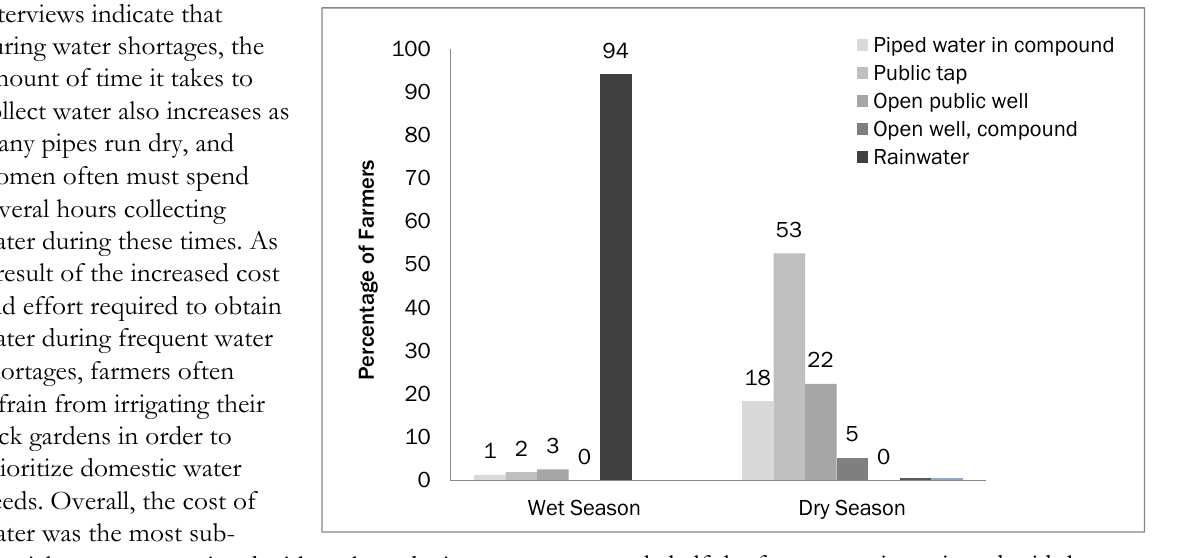
Figure 2. Sources of Irrigation Water for Sack Gardens in Kibera During the Wet and Dry Seasons During the dry season, households used water from a variety of sources to irrigate their sack gardens. In most cases, this water must be purchased ( n